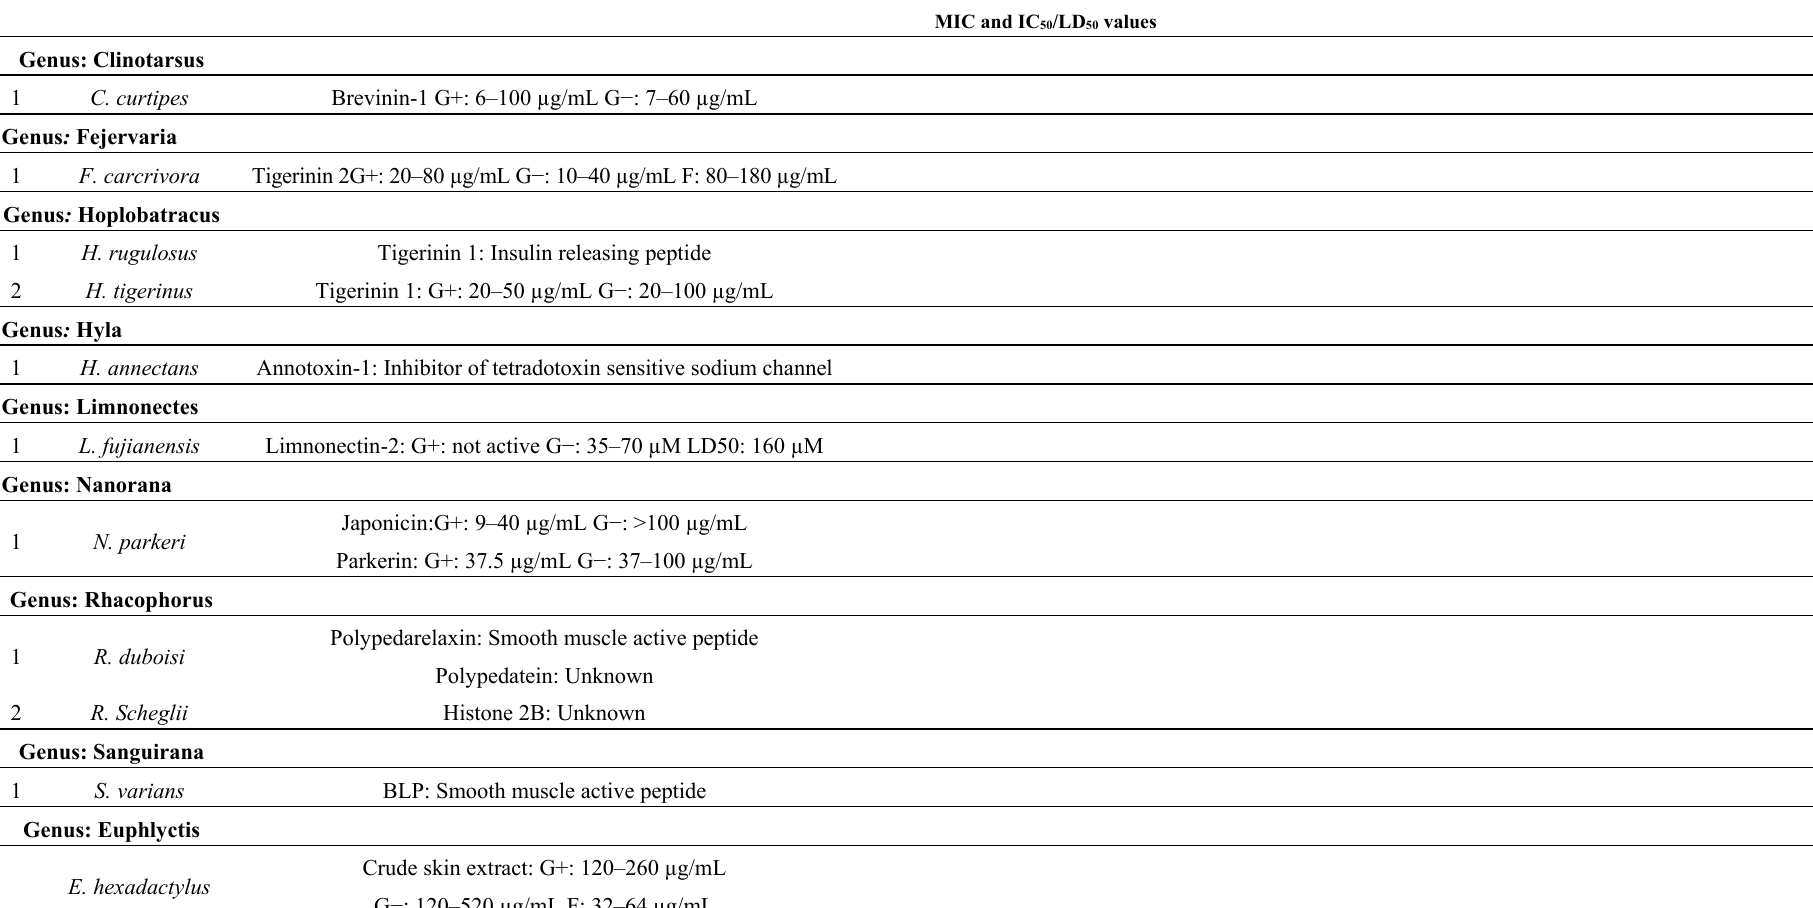
Table 2. Cont . MIC and IC 50 /LD 50